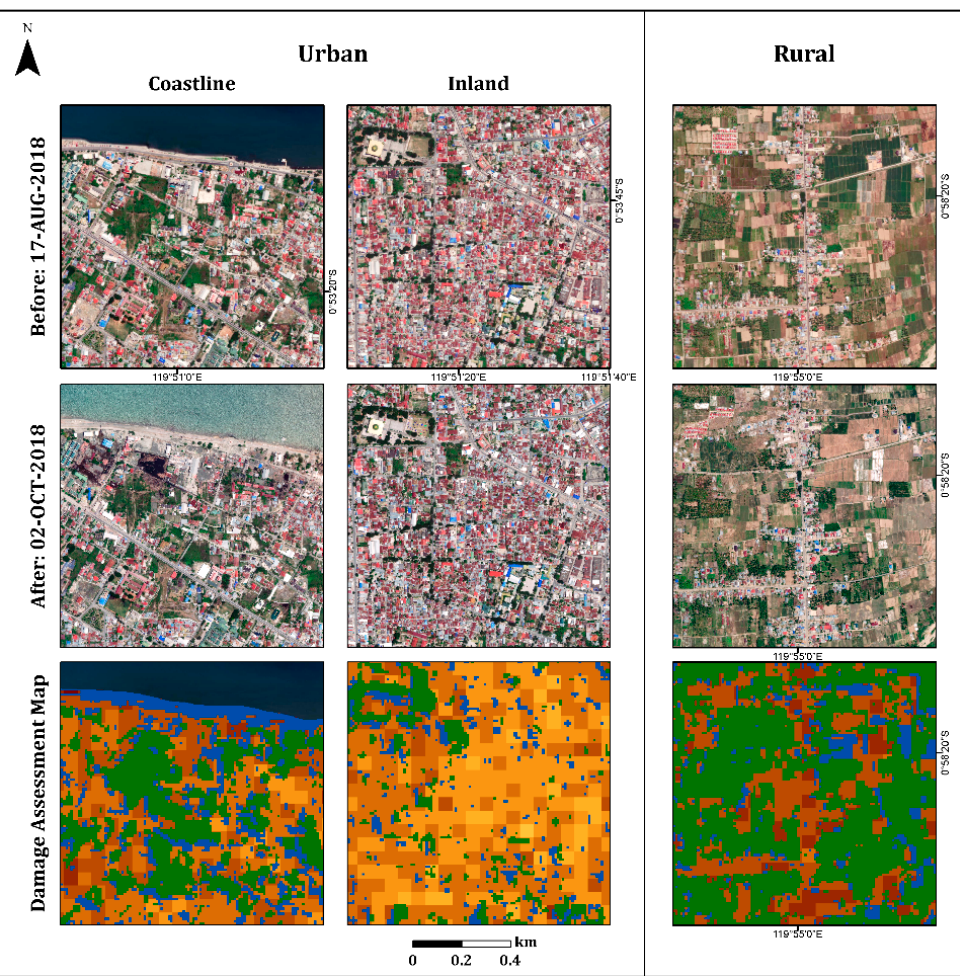
Figure 7. Insets showing selected urban (coastline and inland) and rural areas from the entire scene (Figure 5). Pre-event optical image (17 August 2018), post-event optical image (2 October 2018), and the damage assessment map (see legend in Figure 5).